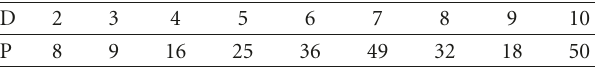
Table 1: Design of α = e j 2 πq/P